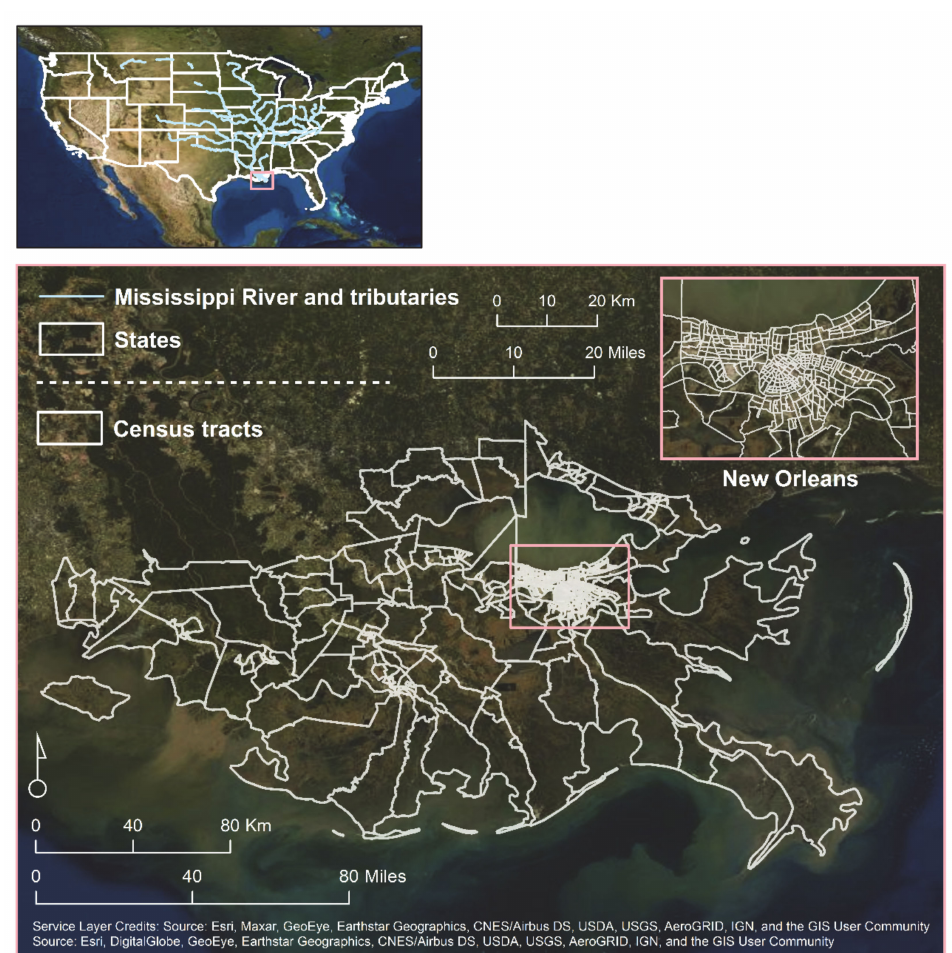
Figure 1. Study area map of census tracts (U.S. Census Bureau 2016) [64] in the Mississippi Delta included, based on the Louisiana State Coastal Zone Boundary (not